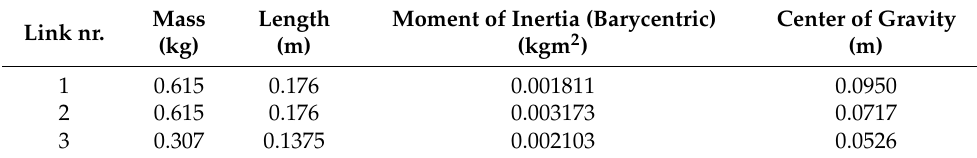
Figure 1. Space robot prototype considered in this work. Table 3. Manipulator geometrical and inertial